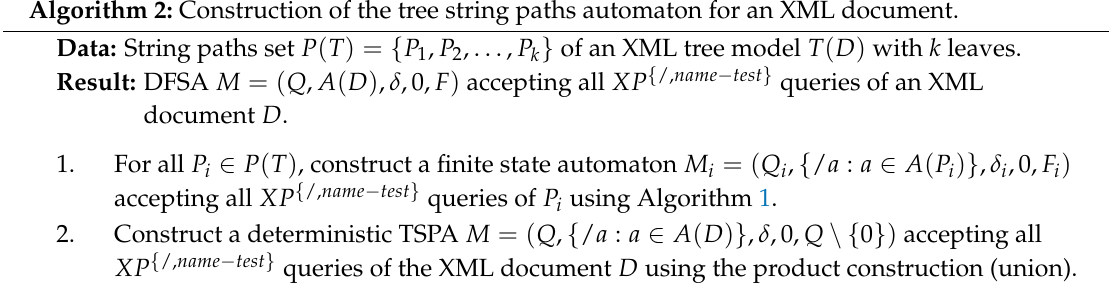
Figure 3. Deterministic tree string paths automaton for the XML tree model T from Figure 1. Algorithm 2: Construction of the tree string paths automaton for an XML